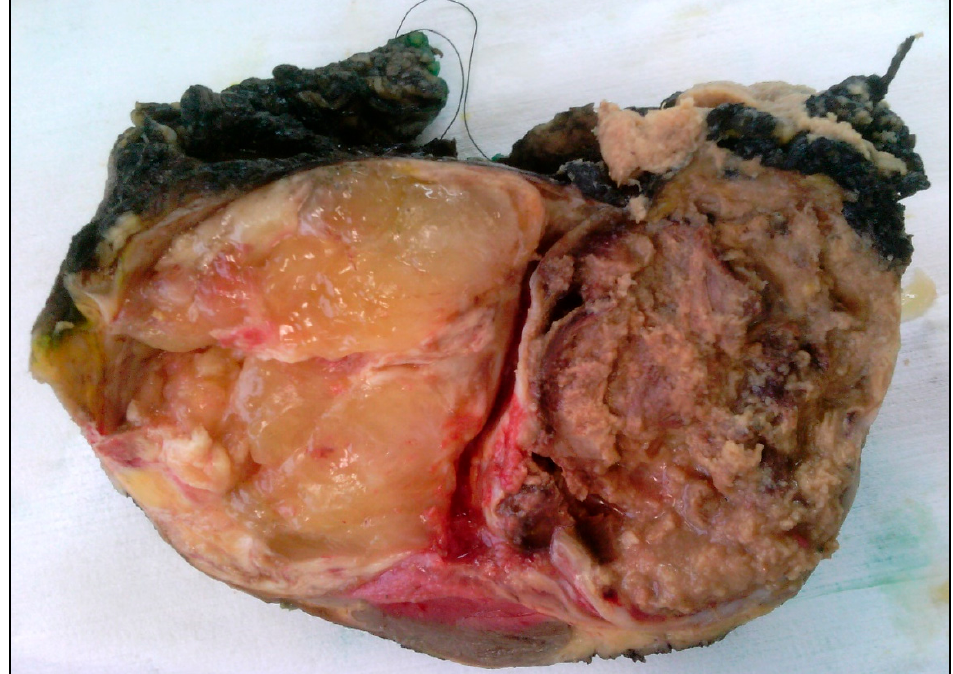
Figure 2. Macroscopic image of a pediatric low-grade myxoid liposarcoma, excised after neoadjuvant radiotherapy. On the left side of the specimen is a smooth, gelatinous area (characteristically seen in tumors of a lower grade). The right side of the specimen shows necrosis, as a result of the preoperative radiotherapy.